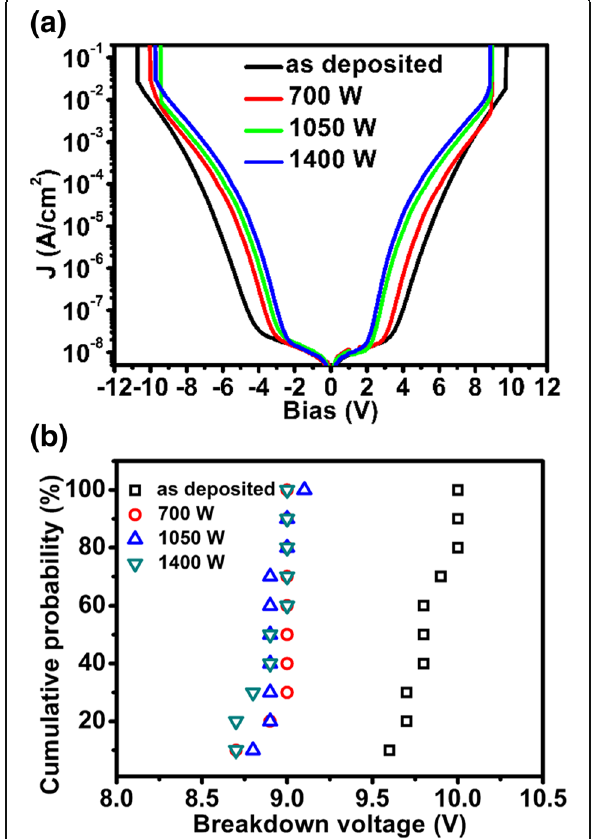
Fig. 3 The curves of the substrate temperature for different samples during the microwave annealing